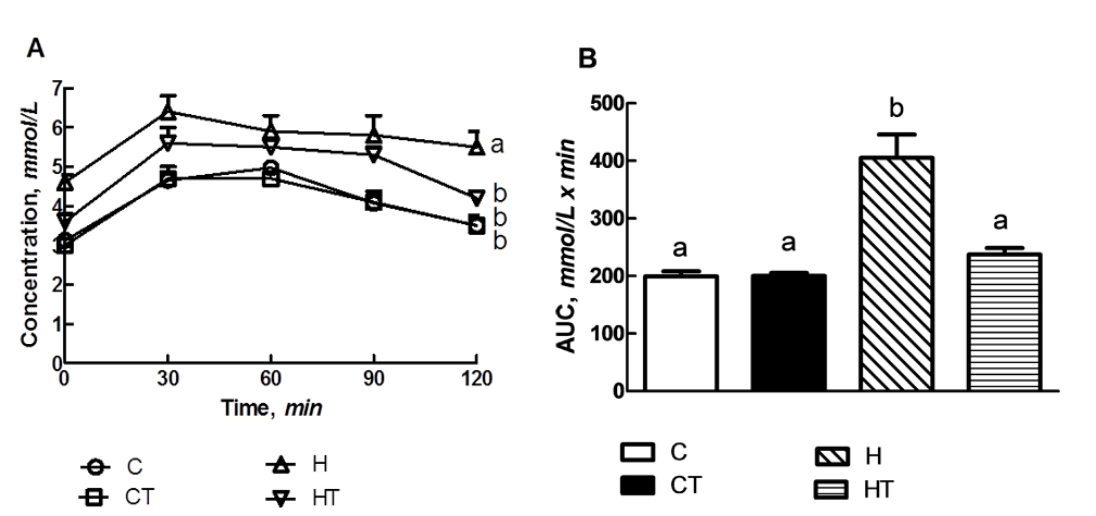
Figure 4. Oral glucose (2 g/kg) ( A ) and insulin (0.33 IU/kg) ( B ) tolerance in C, CT, H and HT-diet fed groups. Data shown as means ± SEM. Endpoint means with different letters in each data set significantly differ. n =